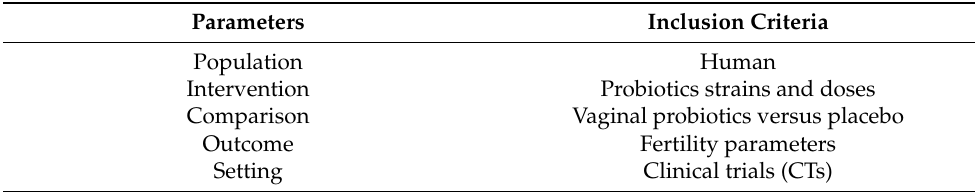
Table 1. Population, intervention, comparison, and outcome (PICO) criteria for inclusion of studies. Parameters Inclusion Criteria Population Comparison Fertility parameters Setting Clinical trials